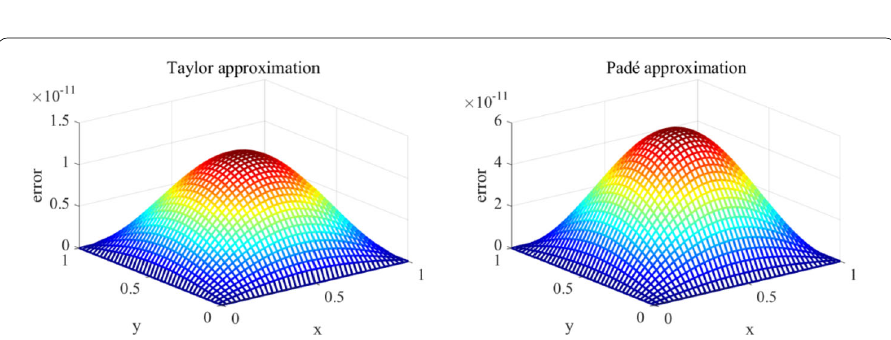
Figure 22 The errors between the exact solutions and CFDS-PIM-SSM approximated solutions of the Taylor approximation (on left-hand side figure), and the errors between the exact solutions and CFDS-PIM-SSM approximated solutions of Padé approximation (on right-hand side figure) for three-dimensional problem at t = 0.1 with z = 0.5 for Example 6